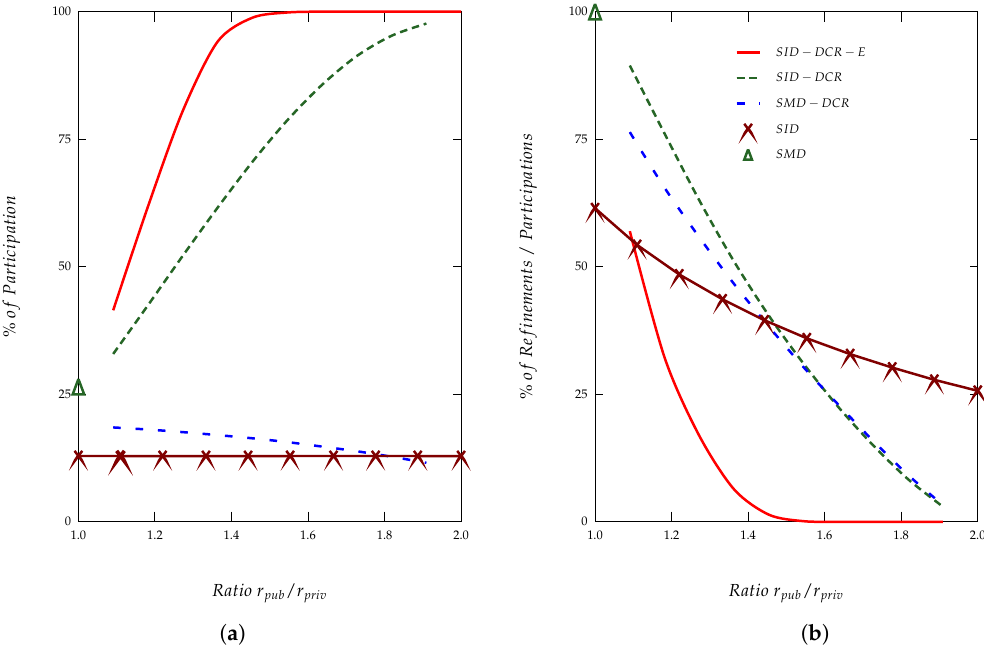
Figure 4. ( a ) Percentage of full participations and ( b ) percentage of refinements over the number of full participations in the DBP-ALP. SID: solution with an interval of possible delays; SID-DCR: solution with an interval of possible delays with double cloaking regions; SID-DCR-E: solution with an interval of possible delays with double cloaking regions and entropy usage; SMD: solution with a delay equal to maximal distance; SMD-DCR: solution with a delay equal to maximal distance with double cloaking